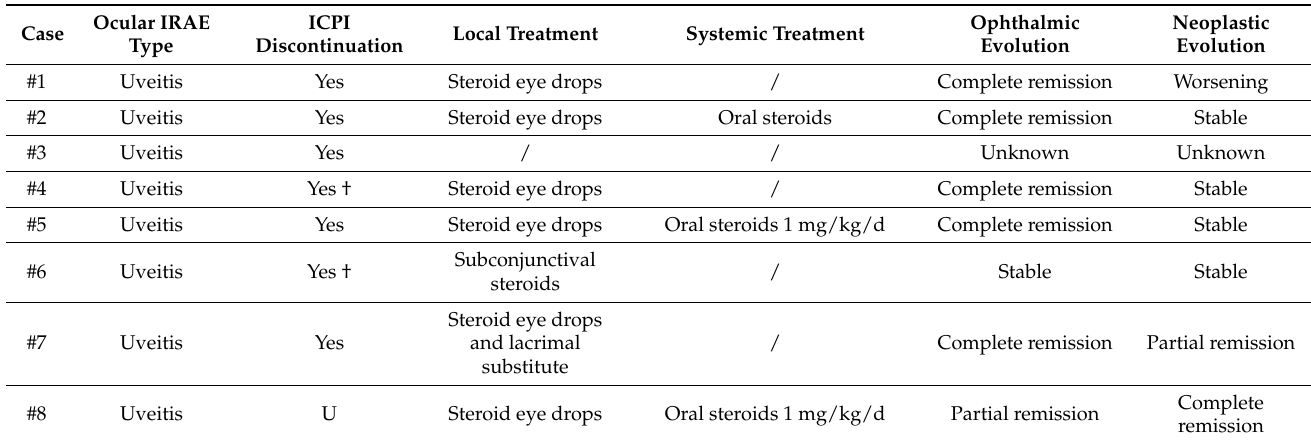
Table 5. Management and outcomes of ocular